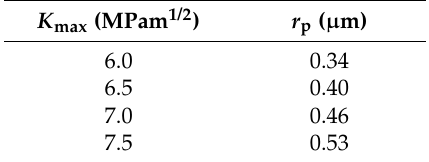
Table 4. Plastic zone sizes at the crack tip calculated for several values of K max .